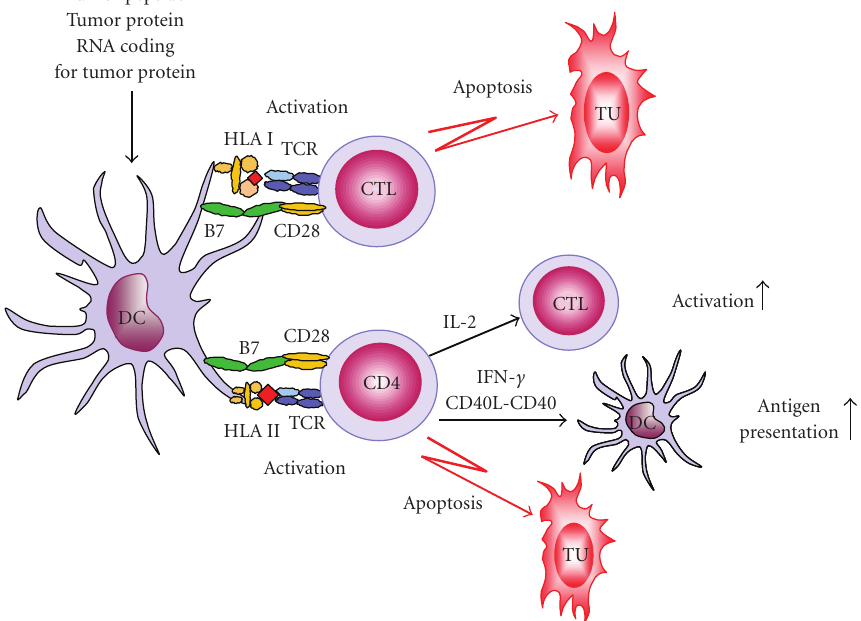
Figure 1: DC-based immunotherapeutic strategies for prostate cancer. DCs display a unique capacity to induce and maintain T-cell responses and emerged as promising candidates for vaccination strategies in prostate cancer therapy. Thus, DCs are loaded with PCa- associated antigen-derived peptides, protein, or RNA. Due to their high surface expression of HLA-peptide-complexes and costimulatory molecules, DCs e ffi ciently activate and expand CD8 + CTLs and CD4 + T cells. CD8 + CTLs possess a profound capability to recognize and destroy tumor cells. CD4 + T cells enhance the capacity of DCs to induce CTLs by the interaction between CD40 on DCs and CD40 ligand on activated CD4 + T cells. In addition, they provide help for the maintenance and expansion of CTLs by secreting cytokines and are able to eradicate tumor cells directly. CTLs: cytotoxic T cells; DCs: dendritic cells; HLA: human leukocyte antigen; IL: interleukin; IFN: interferon; TCR: T cell receptor; TU: tumor